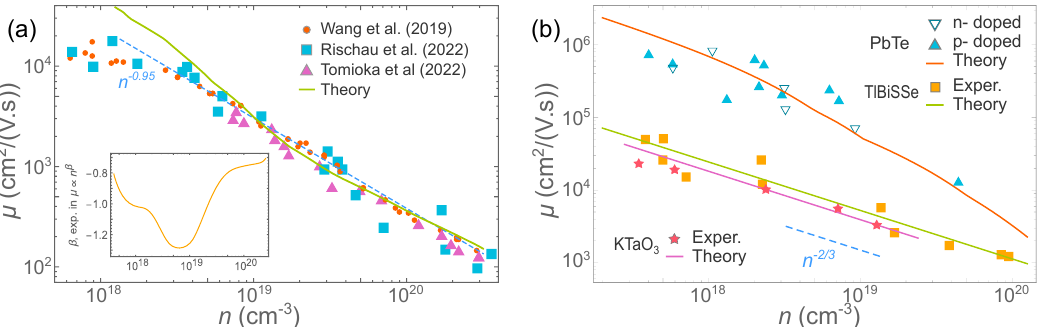
Figure 3: The mobility µ in log scale (vertical) vs electron density in log scale (hor- izontal). (a) The red circles, blue squares and magenta triangles correspond to the experimental data for SrTiO extracted from [ 2–4 ] respectively, and the green line 3 − x represents the theoretical model Eq. (10). The inset focuses on the local exponent β = − d ln µ/ d ln ( n ) , which varies between − 0.8 and − 1.2, averaging at − 0.95; and the scaling n − 0.95 depicted with a dashed blue line. (b) Blue triangles illustrate the data for PbTe extracted from Ref. [ 1, 8, 9 ] . The red line employs our theoretical model with the effective electron mass found in [ 29 ] (see Fig. 4 in the Supplement). The orange squares and red stars indicate the mobility data for TlBiSSe [ 1, 14 ] and [ 7 ] . The green and pink lines represent the theoretical results for electron mo- KTaO 3 bility in these materials, using constant effective masses m = 0.14 m and m = 0.5 m 0 0